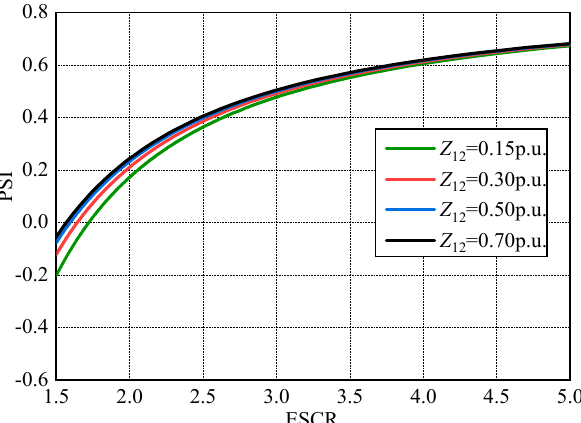
Figure 8. Curves of PSI versus ESCR for different Z 12 under VSC-HVDC constant reactive power control mode.